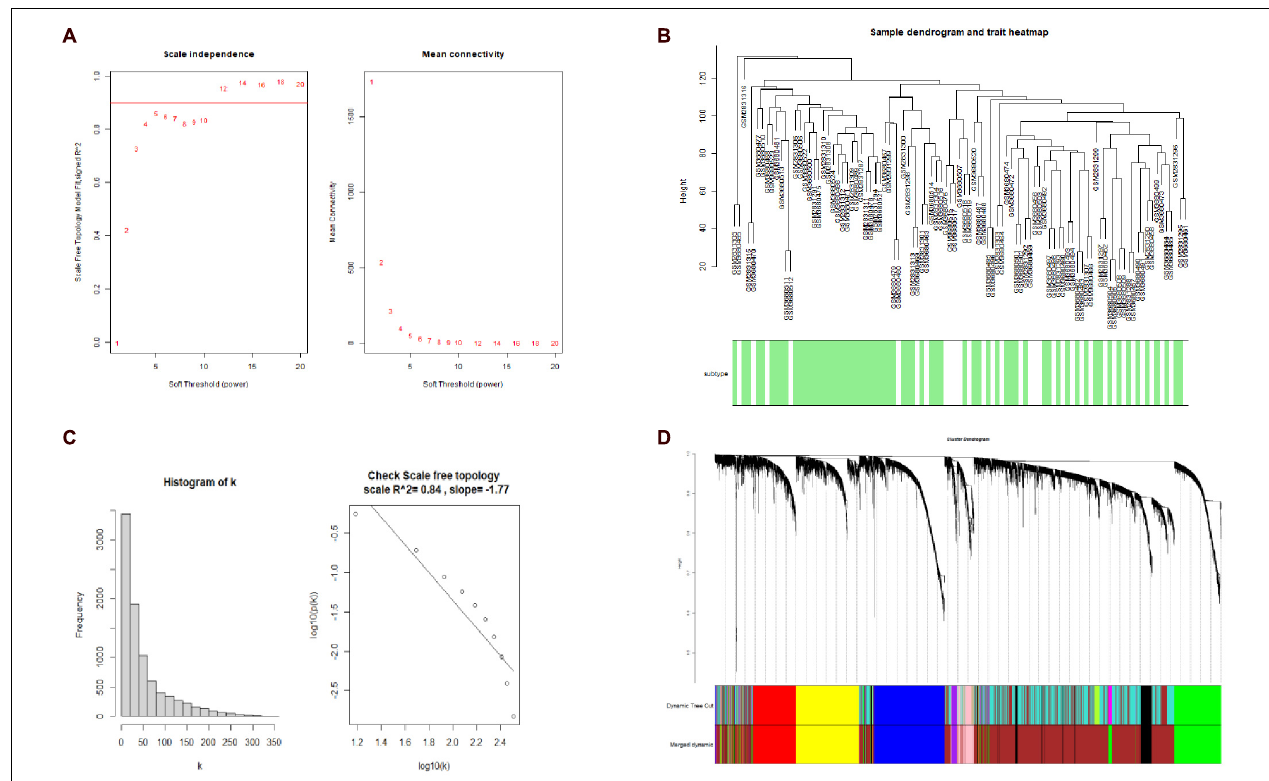
FIGURE 2 | Weighted-gene correlation network analysis (WGCNA). (A) Analysis of the scale-free topology model fit index for soft threshold powers ( β ) and the mean connectivity for β . (B) Histogram of K and check scale-free topology. (C) Sample clustering for detecting outliers, and sample dendrogram and trait heatmap. (D) Cluster dendrogram, dynamic tree cut and merged dynamic color